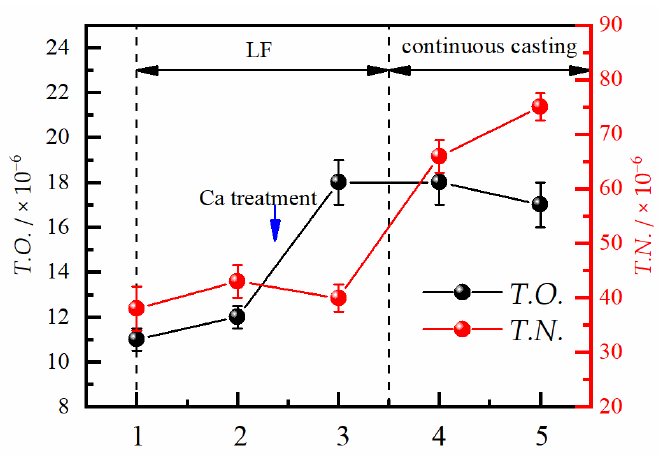
Figure 2. Changes in T.O. and T.N . contents during the whole process in steel.